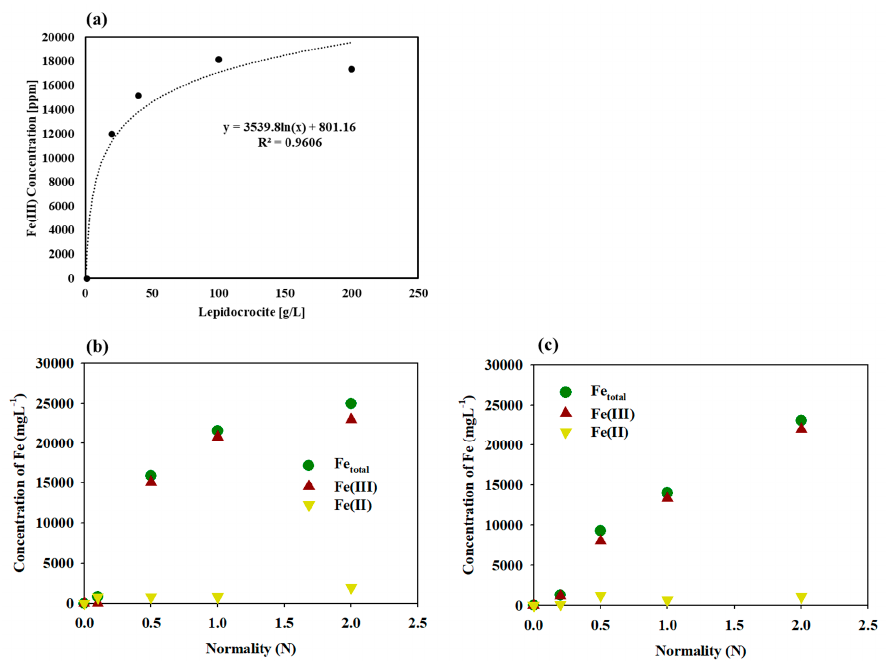
Figure 3. Concentrations of Fe ions under different variables; ( a ) Fe 3+ dissolution at different amounts of lepidocrocite (2 N HCl), ( b ) at different normality of HCl, and ( c ) H 2 SO 4 . Experimental conditions: ( b , c ) [minerals]0 = 40 g·L − 1 . ( b , c ) [minerals] 0 = 40 g · L − 1